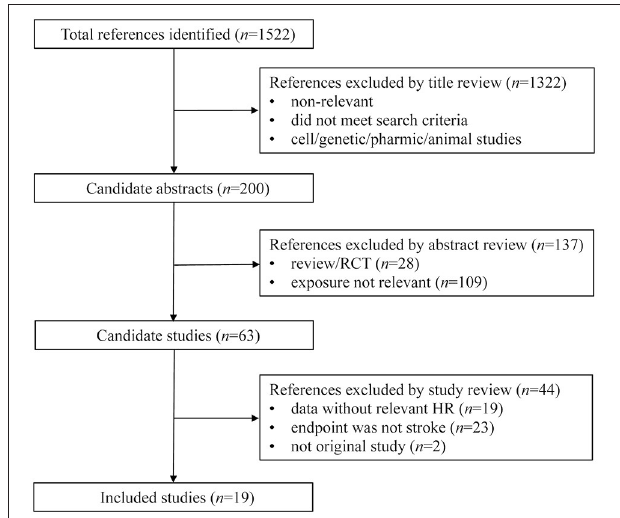
FIGURE 1 | Flow chart of records retrieved, screened and included in this meta-analysis.